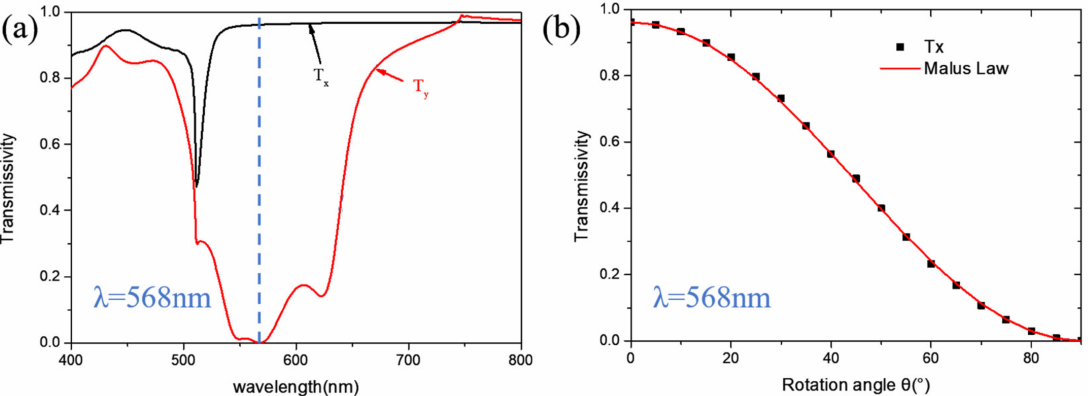
Figure 2. The structural parameters are L = 80 nm, W = 210 nm, H = 400 nm, and P = 510 nm. ( a ) The distribution of transmittances T x and T y in the visible light. ( b ) The transmittance distribution of x‑linearly polarized light through the rotated unit